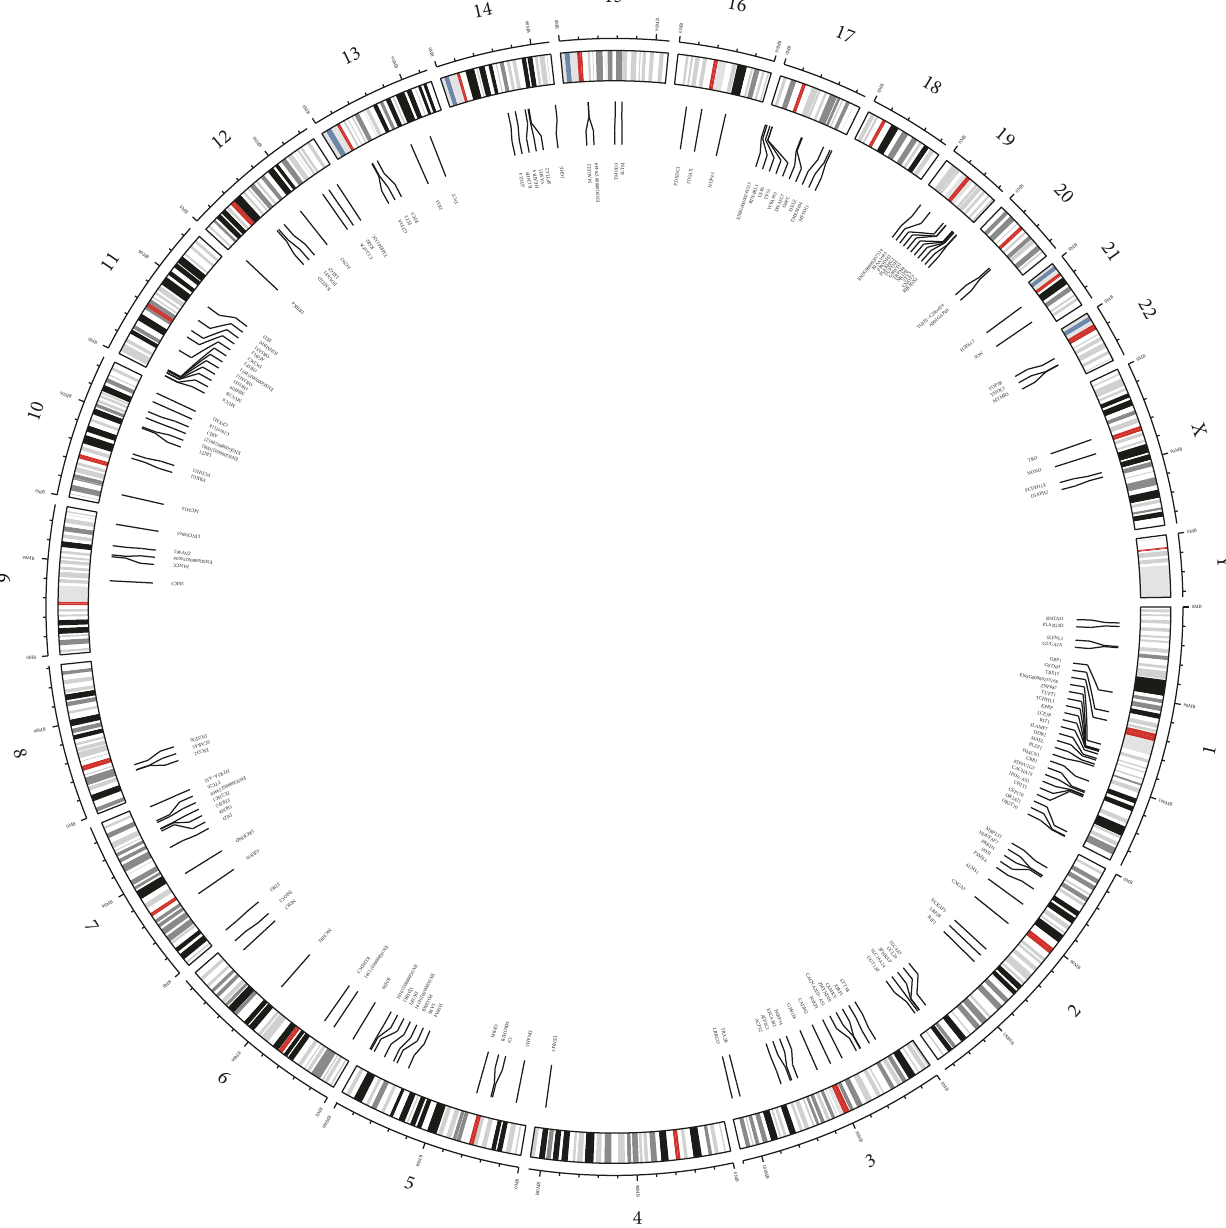
Figure 7: Distribution of hypermethylated genes in chromosomes. Commonly hypermethylated genes in AML are randomly distributed across the chromosomes. Chromosome 1 contains the highest number of genes than any other